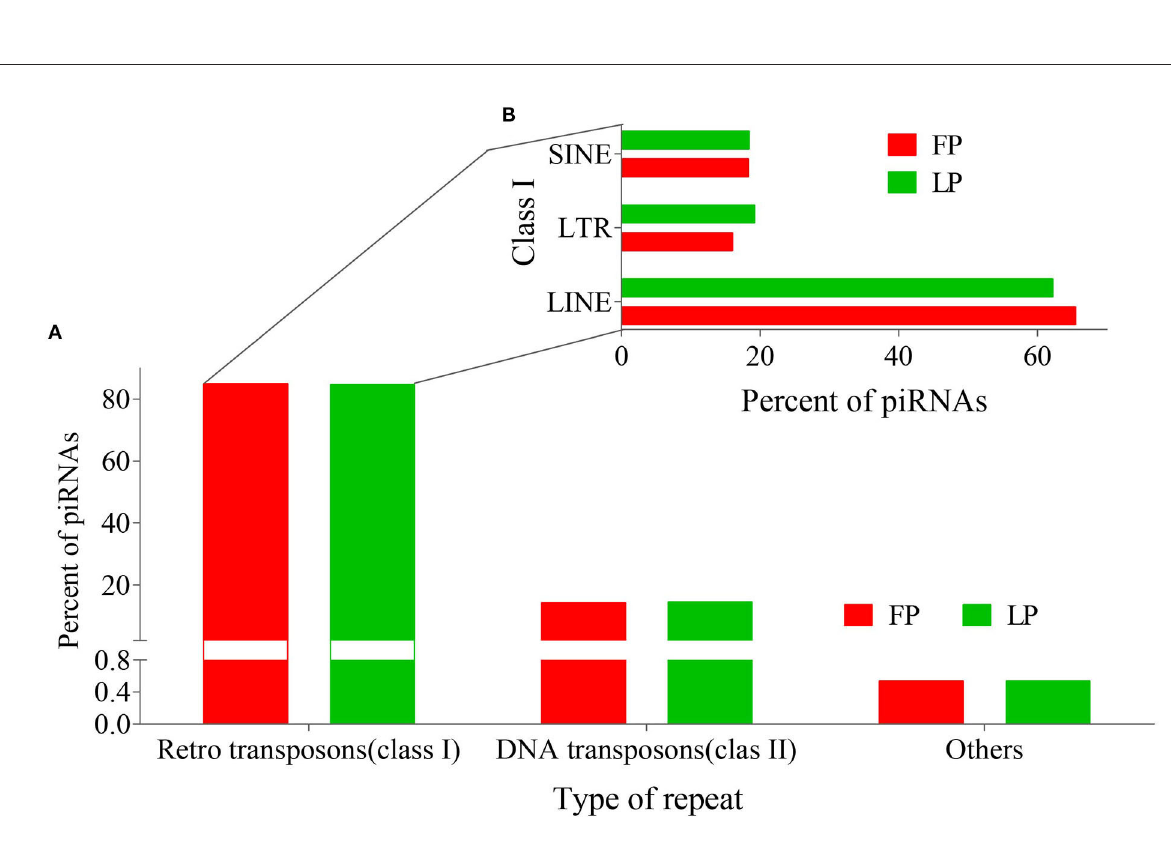
FIGURE5 Distribution of origin of FP and LP-piRNAs among (A) Repeats and (B) Retro